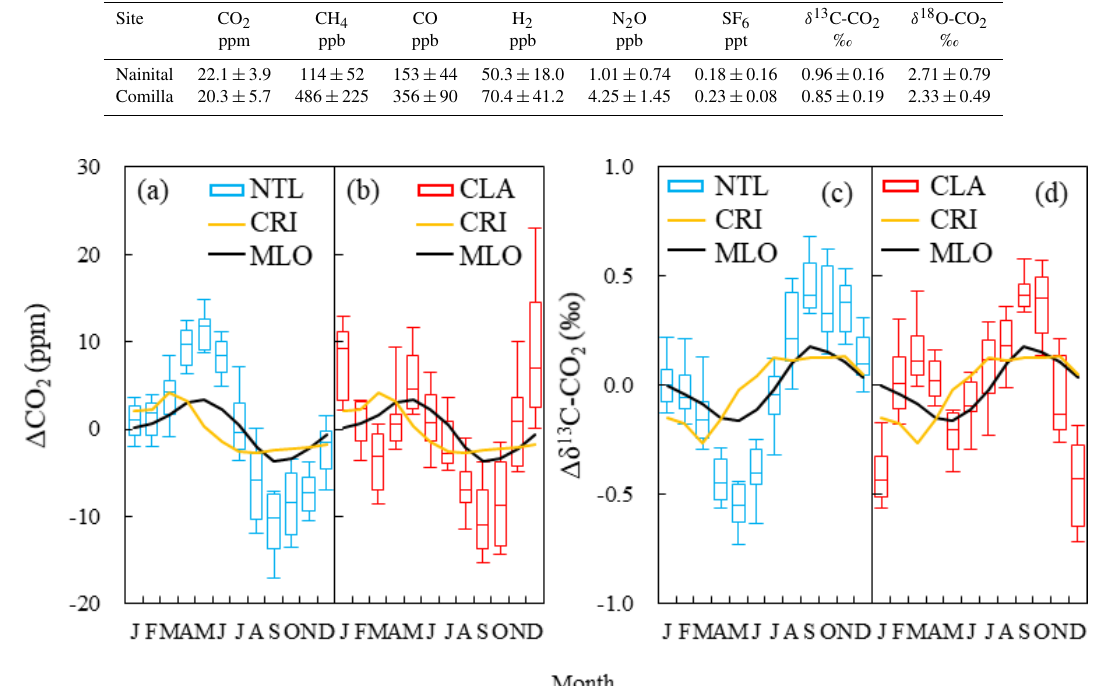
Figure 6. Seasonal variations in the CO 2 mole fraction at (a) NTL and (b) CLA and the isotope ratio of δ 13 C-CO 2 at (c) NTL and (d) CLA. Boxes with blue and red are for Nainital and Comilla, and the black and yellow lines are for MLO and CRI, respectively. Median values (the line in the box) and the inner 50th percentile of the value (box) and inner 90th percentile of the value are from the monthly averaged CO 2 mole